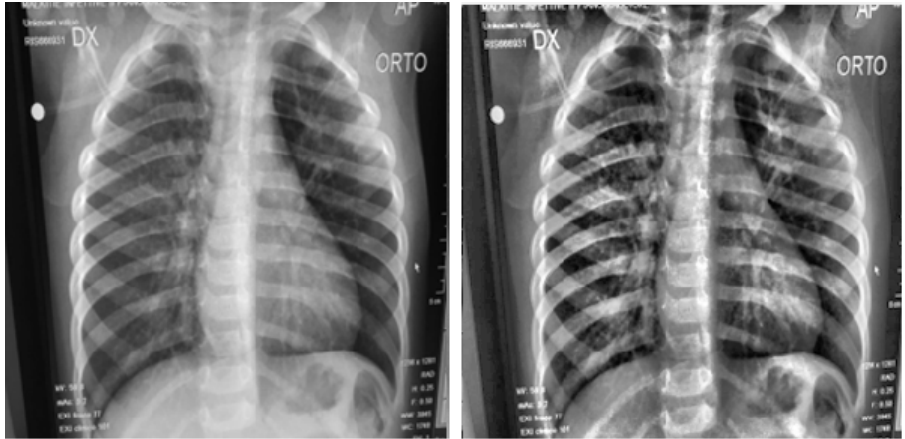
Figure 3. Original image ( left ) and contrast-enhanced image ( right